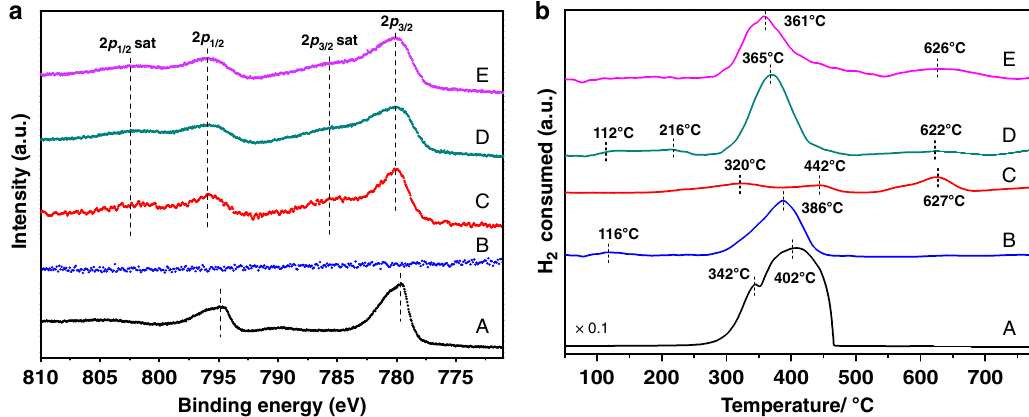
Fig. 3 Electronic structure and chemisorption characterizations. a XPS Co 2 p analysis and b H 2 -TPR pro fi les of (A) Co 3 O 4 as reference, (B) 50Al 2 O 3 /Pt, (C) CoO x /50Al 2 O 3 , (D) CoO x /50Al 2 O 3 /Pt, and (E) CoO x /100Al 2 O 3 /Pt.